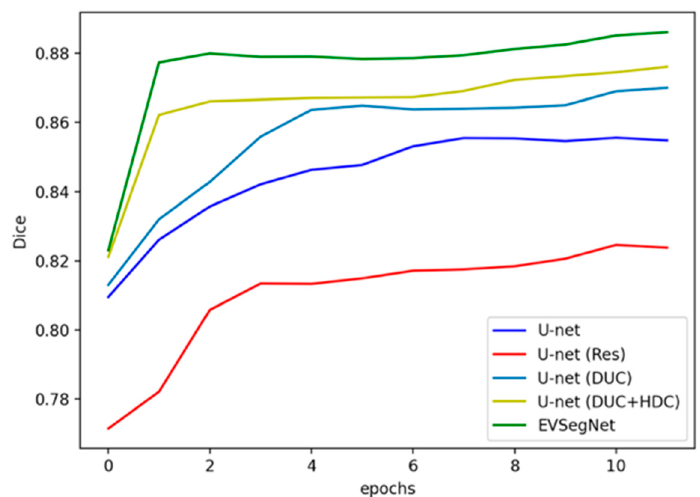
Figure 8. The Dice comparison of 11 epochs for different models for the test dataset.